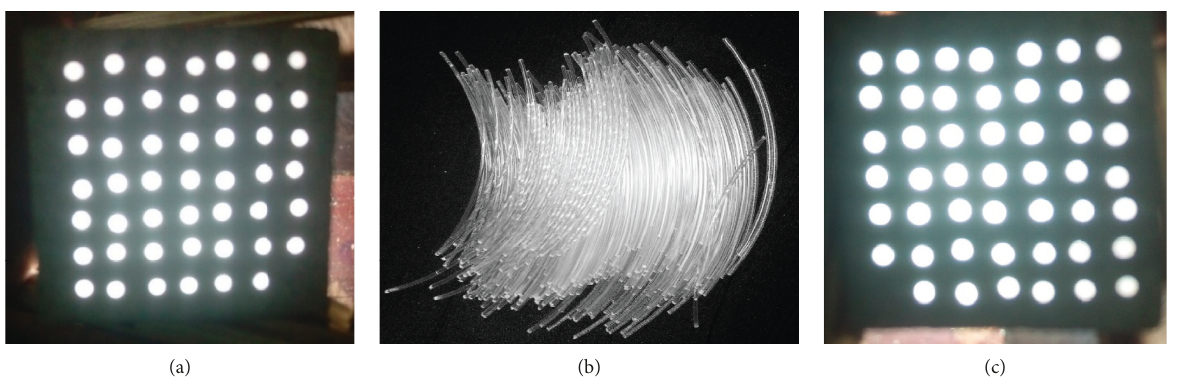
Figure 2: Typical translucent concrete specimens and plastic optical fiber. Table 6: Details of POF integrated on translucent concrete